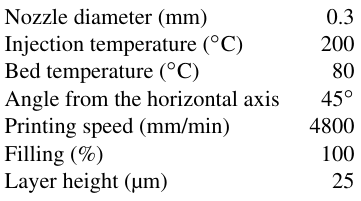
Table 1. 3D printing parameters.